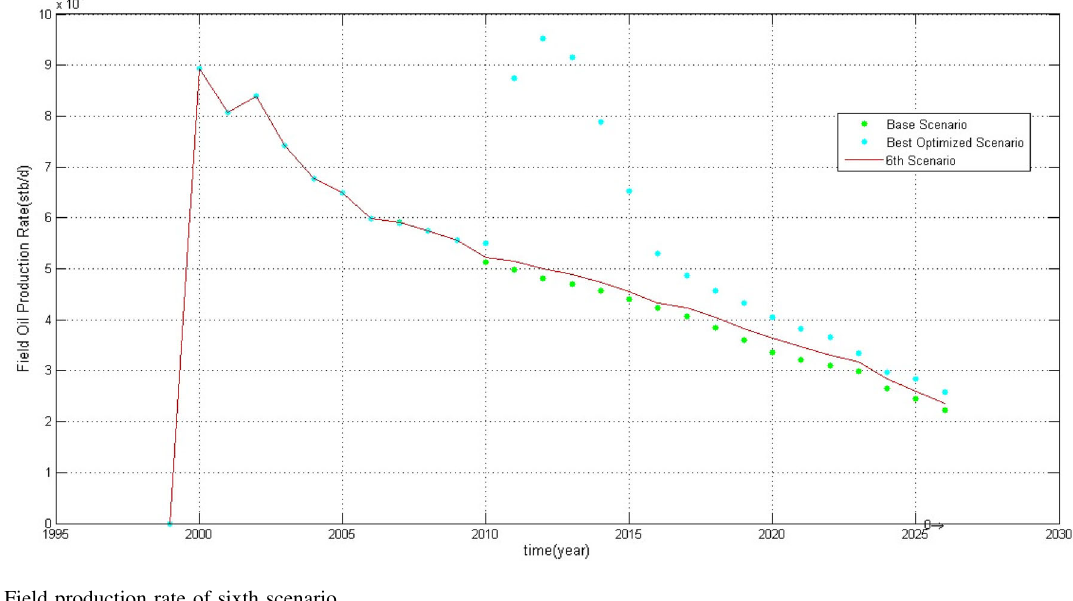
Fig. 13 Field production rate of sixth scenario